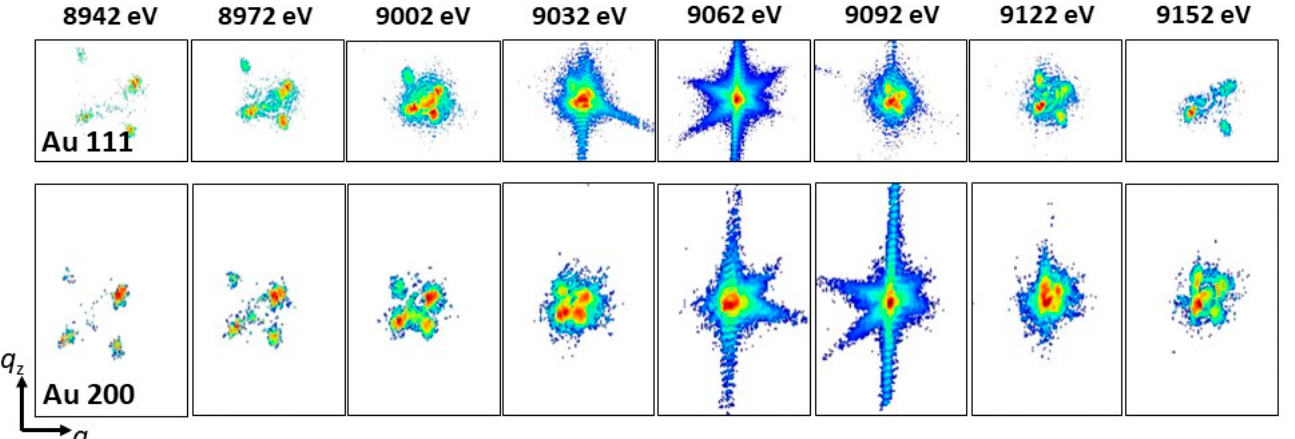
Figure 3. Sequences of 2D coherent diffraction patterns of the Au 111 and Au 200 Bragg peaks during a scan of the energy of the incident X-ray beam.